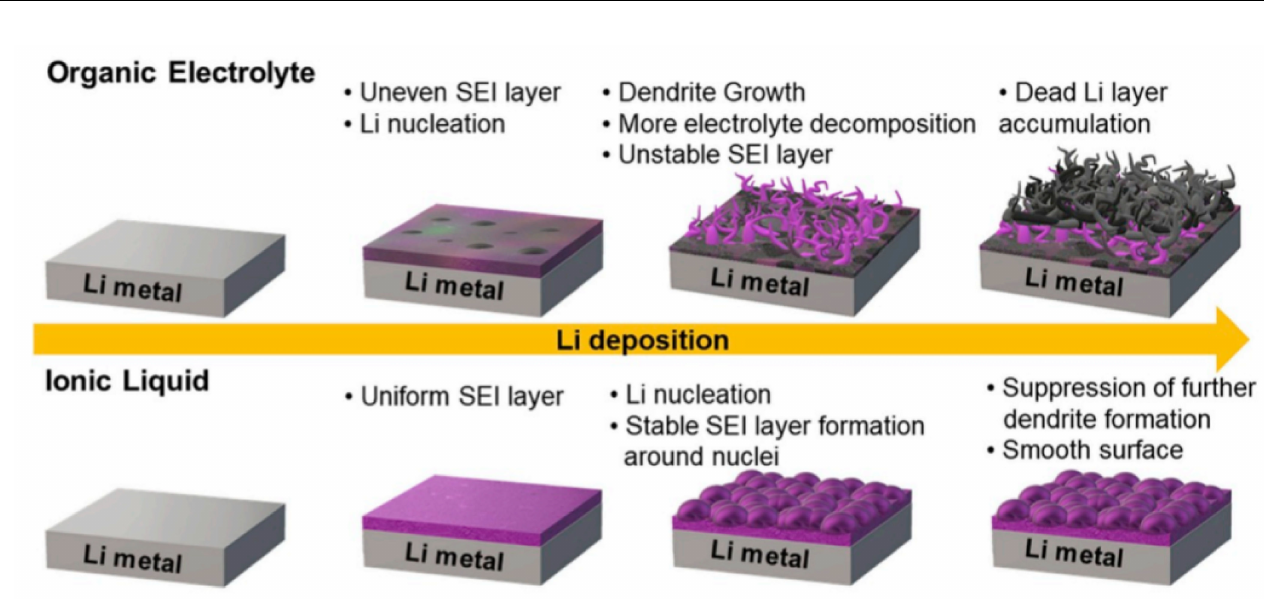
Figure 27. Comparative illustration of Li dendrite deposition in organic and ionic electrolyte (adapted with permission from [267]. Elsevier,